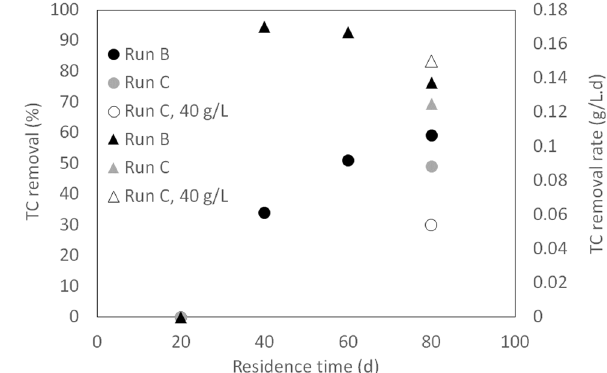
Fig. 5 Comparison of model and experimental results. a Run A; b Run B; c Run C